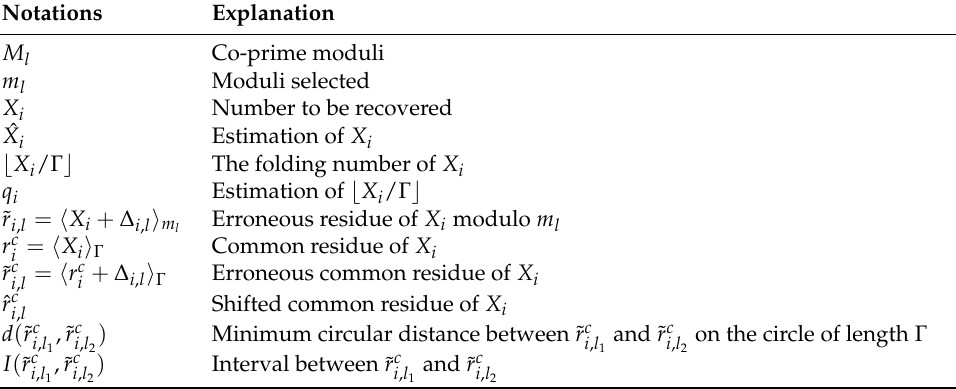
Table 1. List of